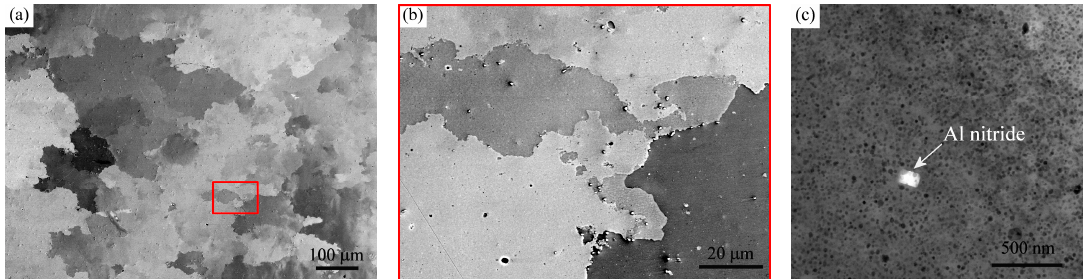
Figure 2. Scanning electron microscopy (SEM) micrograph (in BSE) of the microstructure of ODS alloy tested at 800 °C ( a ) overview; ( b ) detail of area in red rectangle in higher magnification; ( c ) STEM micrograph showing Y 2 O 3 nanoparticles and occasional Al nitride particle.